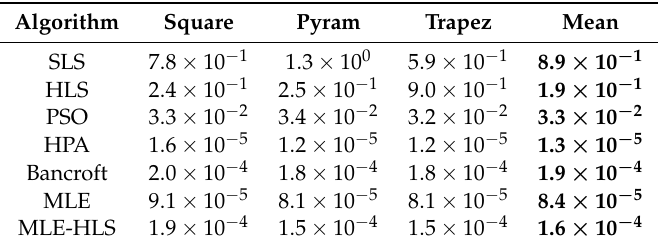
Table 5 highlights the mean computational time for one source location for each algorithm for every antenna configuration. Table 5. Summary of the mean computational time spent, in seconds, for each position analysed in theoretical conditions by each algorithm.